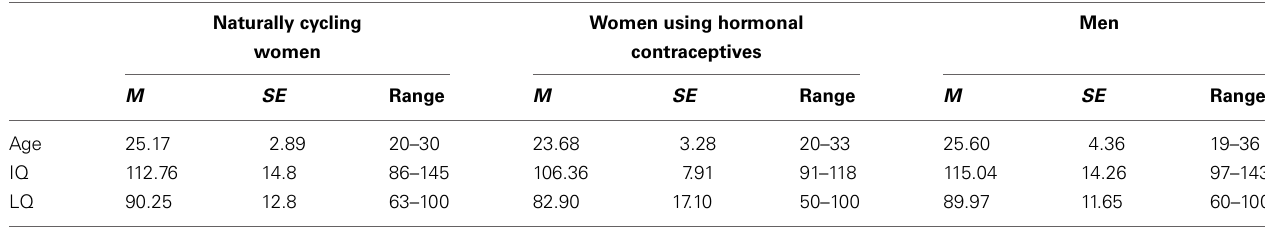
Table 1 | Age, IQ, and LQ of naturally cycling women, women using hormonal contraceptives, and men. Naturally